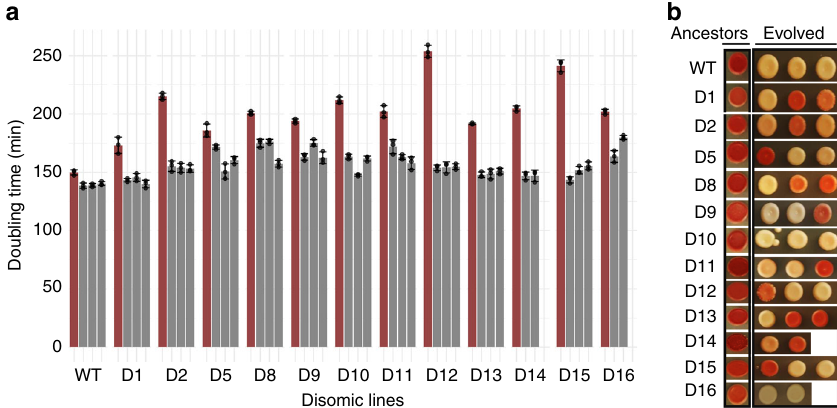
Fig. 1 Phenotype changes in evolved aneuploid yeast lines. a Doubling time of ancestor and evolved lines. Cells were grown at 30 °C, and OD 600 measurements were taken at 15 min intervals using a Biotek-Epoch2 instrument until the cells reached early stationary phase. Doubling time was calculated with a custom R script by analyzing fi tting spline function from growth curve slopes. Bar graphs represent mean of three measurement and error bars are SEM. Red bars represent the doubling time of ancestor strains for both WT and disomes. Black bars show the doubling time of evolved lines for corresponding strains. Mean values are shown; error bars represent SD. Source data for doubling times is presented as source data fi le. b Color changes from red to white in evolved